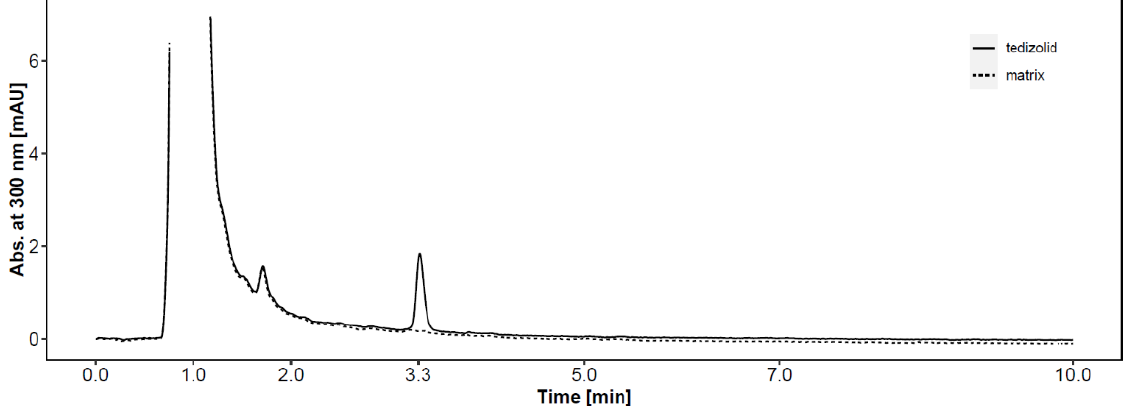
Figure 2. Chromatograms for tedizolid (TDZ) at 300 nm (at 3.3 min, 0.5 mg/L) (solid line) and matrix (dashed line) obtained during the method validation. Eluents (25% acetonitrile, 75% of 0.1% formic acid, isocratically).